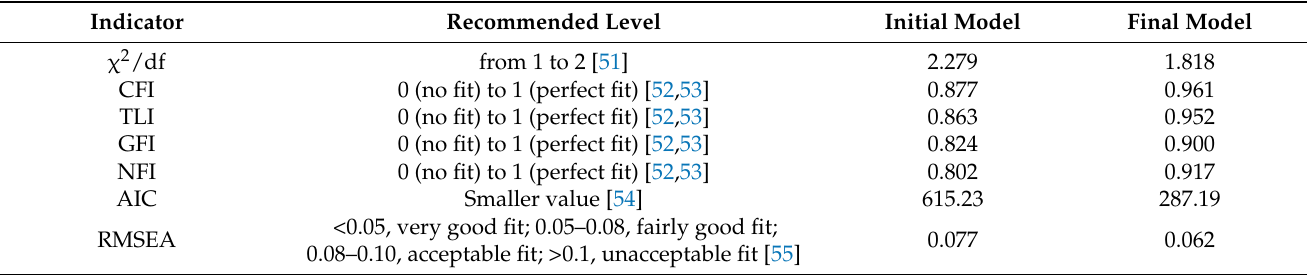
Table 6. Goodness-of-fit results.